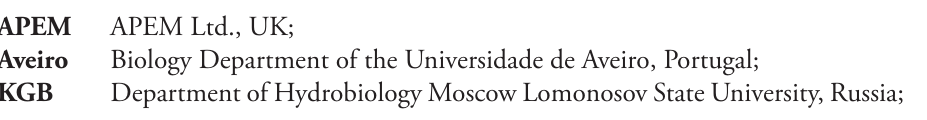
BS1 means branchiferous segment 1). Institutional abbreviations used are as